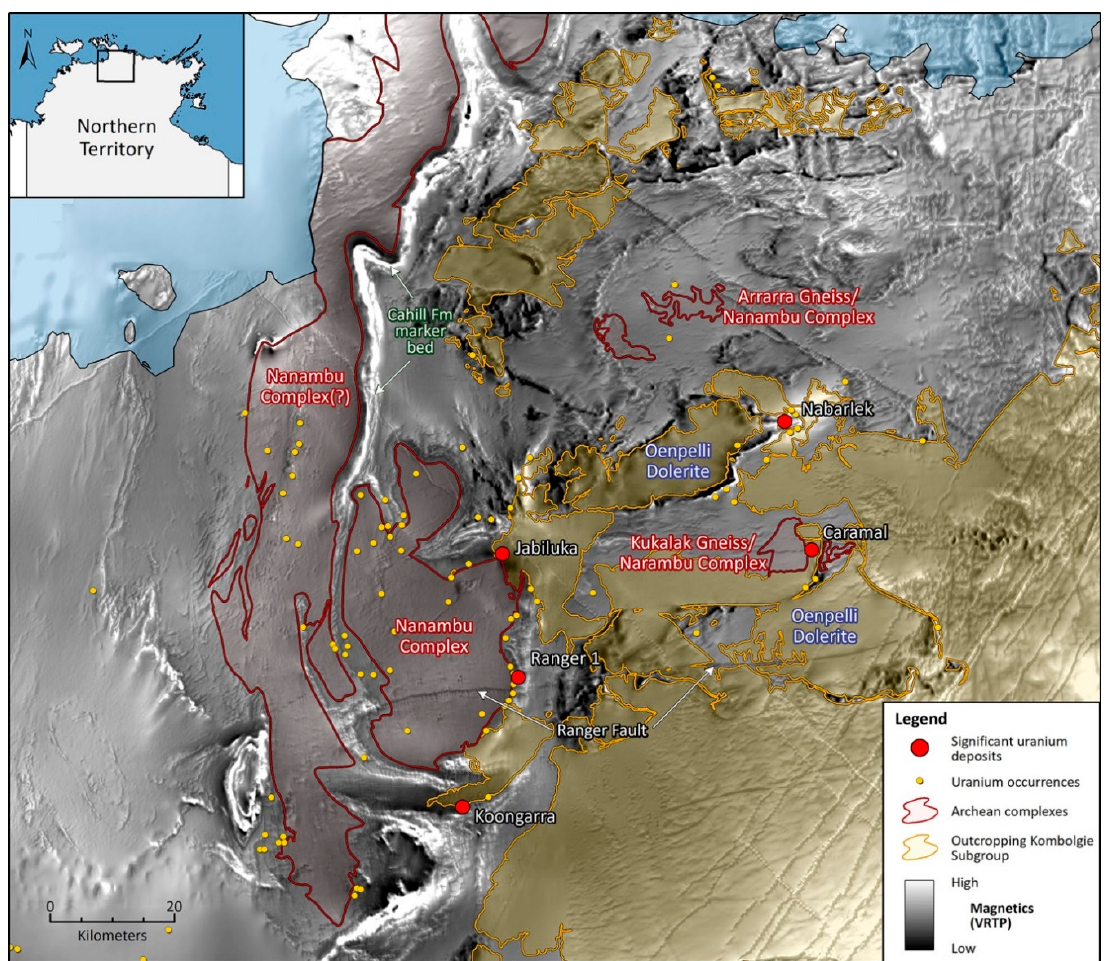
Figure 5. Geological interpretation overlaid on magnetic data—Alligator Rivers Uranium Field. An area of subdued magnetic response corresponds to the Archean Nanambu Complex, adjacent to the Ranger mine and Jabiluka uranium deposit. An elongated, N-S trending zone of similarly uniform low magnetic response further west is interpreted [114] as an undercover extension of the Nanambu Complex. Geochronological analysis has also confirmed the presence of Archean basement rocks in the vicinity of the Nabarlek and Caramal uranium deposits. Several conspicuous areas of the uniform negative magnetic response, bounded by high amplitude curvilinear anomalies in the eastern part of the image are attributed to subhorizontal sheets of Oenpelli Dolerite. The lozenge-shaped sills are surrounded by a disorderly array of high amplitude magnetic anomalies that are interpreted as partially preserved outcrops of dolerite. Numerous linear dykes with long strike-lengths are evident in the southeast and diagonally cross-cutting the image.